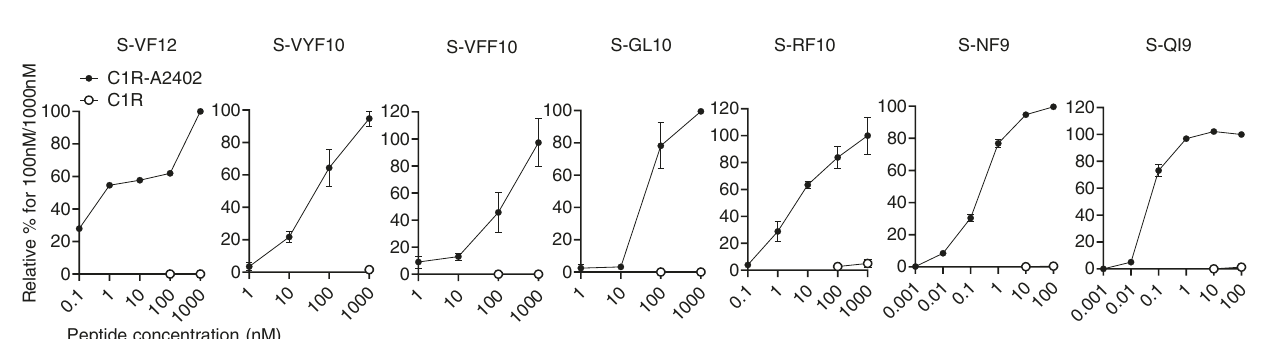
concentrations of peptides. Relative % response to maximum response at 100 or 1000nMwerepresented.ThedataarepresentedasthemeanandSD( n =3)except for S-VF12-speci fi c T cells. Gating strategy in fl owcytometry analysis is shown in Supplementary Fig. 1a. Source data are provided as a Source Data fi